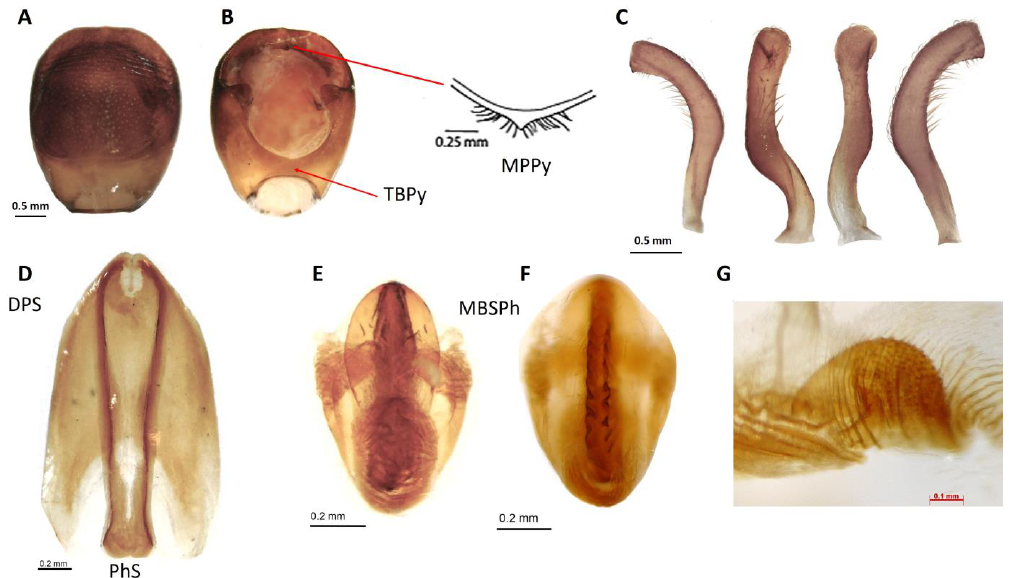
Figure 5. Male genitalia of T. yelapensis sp.nov. ( A ) Pygophore (ventral view); ( B ) pygophore (dorsal view); ( C ) parameres in ventral, inner, outer, dorsal views; ( D ) sclerites of phallosoma (ventral view); ( E , F ) sclerites of phallosoma (dorsal view); ( G ) endosomal process. Abbreviations: dorsal phallotecal sclerite (DPS); medial basal sclerite of phallosoma (MBSPh); median process of pygophore (MPPy); phallosoma support (PhS); transverse bridge of pygophore (TBPy).